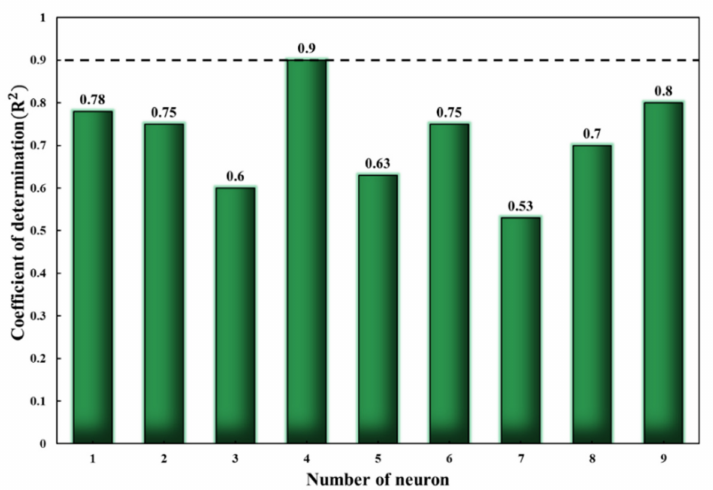
Figure 10. The variation of R 2 for the ANN model with the different number of neurons from 2 to 10 in the hidden